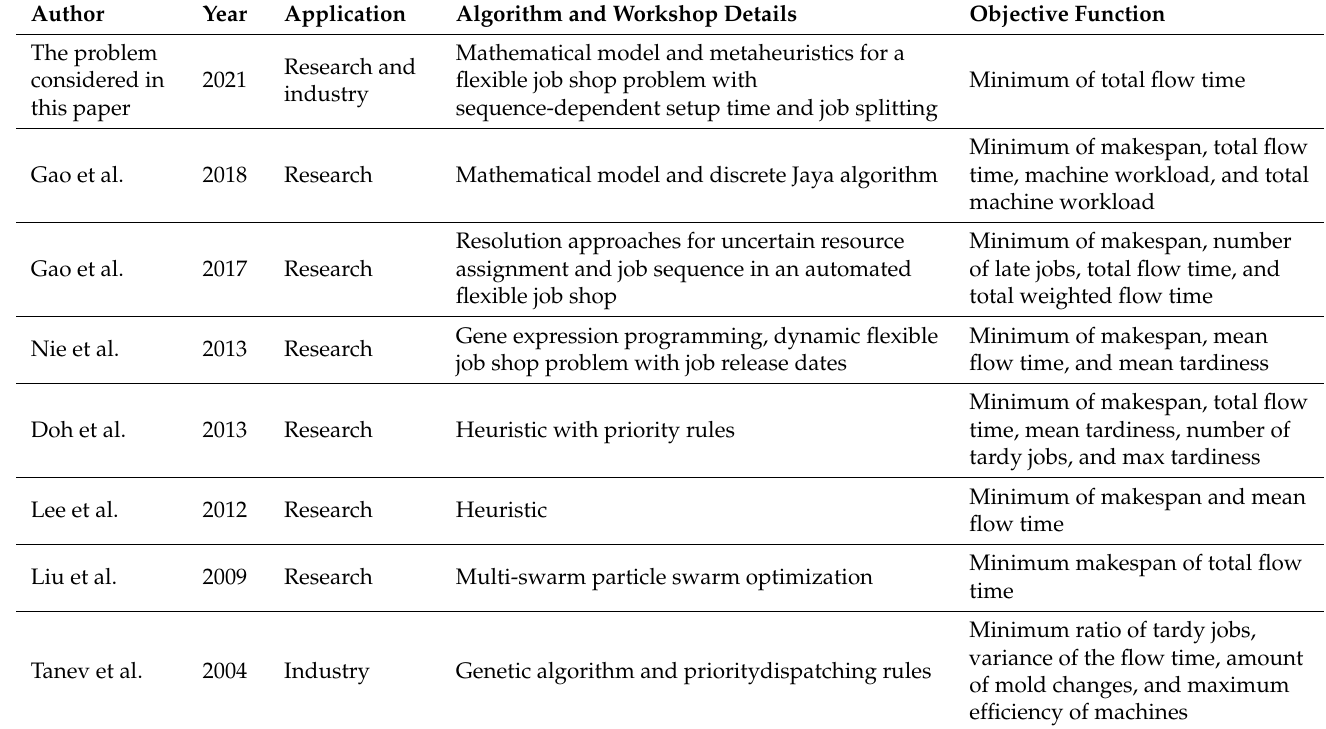
Table 1. Some research works on flexible job shop problems with flow time